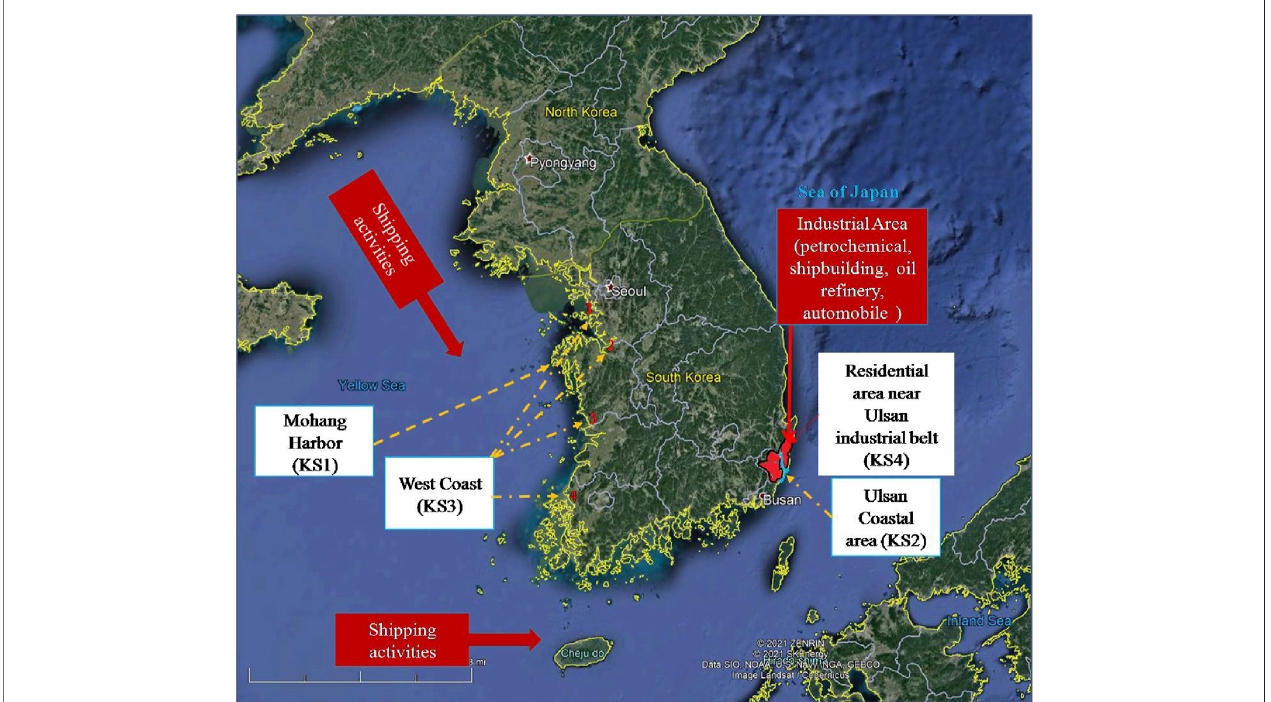
FIGURE 1 | Location of the study